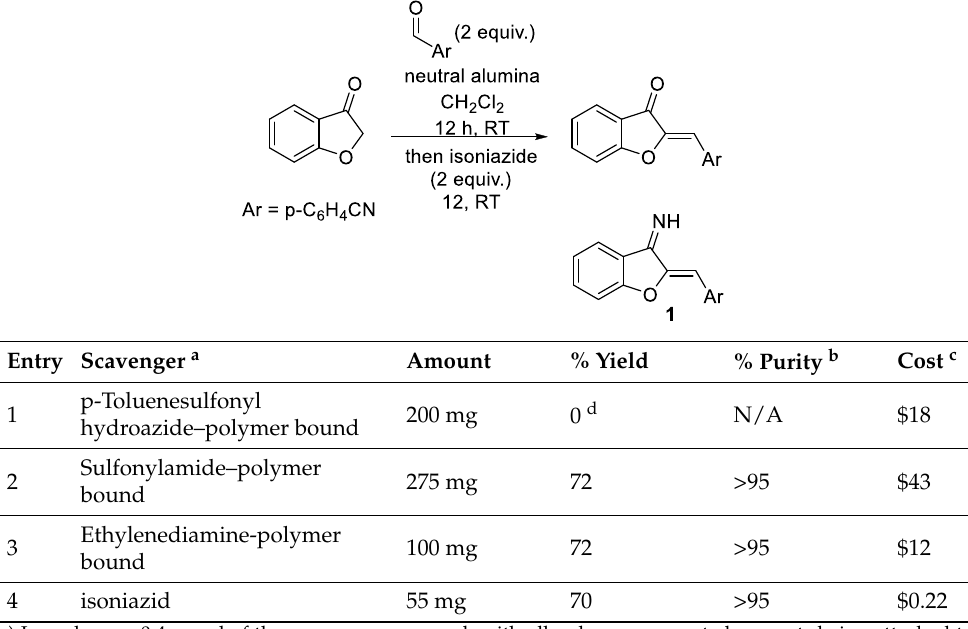
Table 1. Scavenging studies using different scavengers.